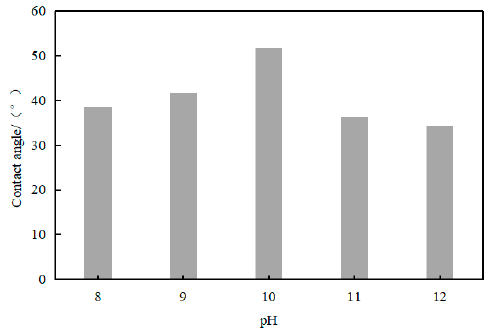
Figure 13. The contact angle variation of solid-free drilling fluid pH to sample.